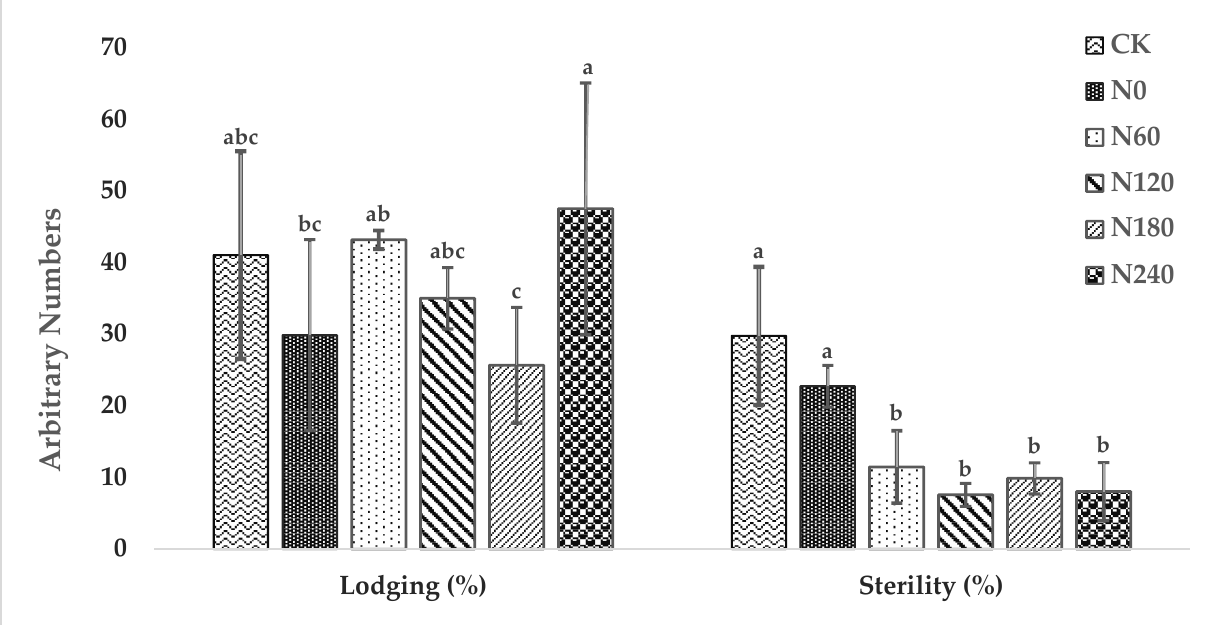
Figure 2. Lodging and Sterility observed in different treatments influenced by varying doses of Nitrogen. CK; control treatment, N0; 0 kg ha −1 N, N60; 60 kg ha −1 N, N120; 120 kg ha −1 N, N180; 180 kg ha −1 N, N240; 240 kg ha −1 N. Similar letters across the treatments indicate a non-significant effect ( p ≤ 0.05).